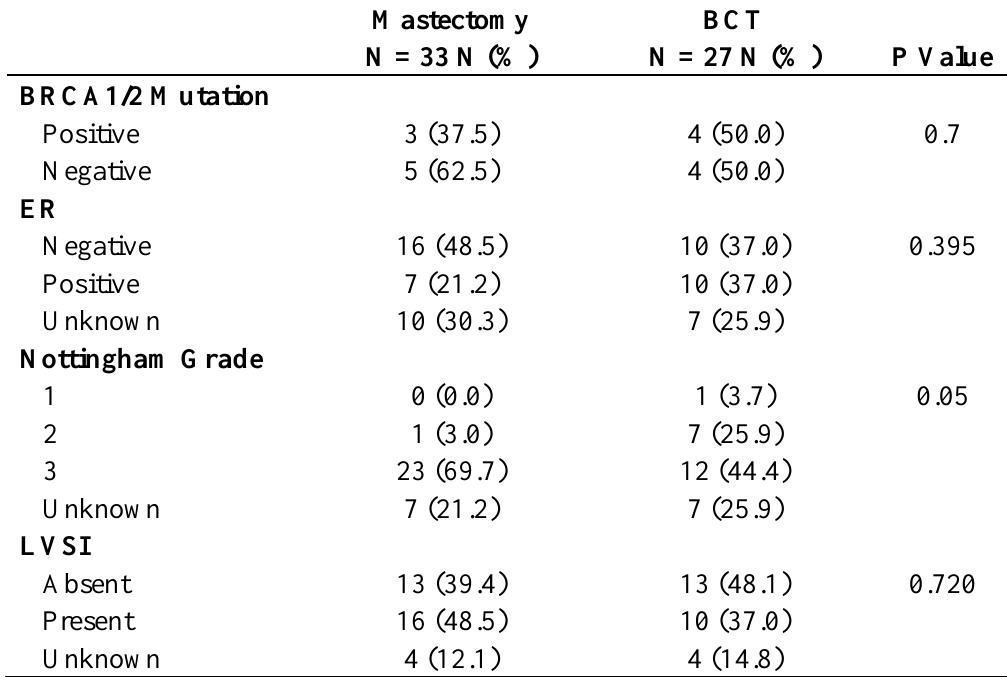
Table 2. Tumor Characteristics by Treatment Group.